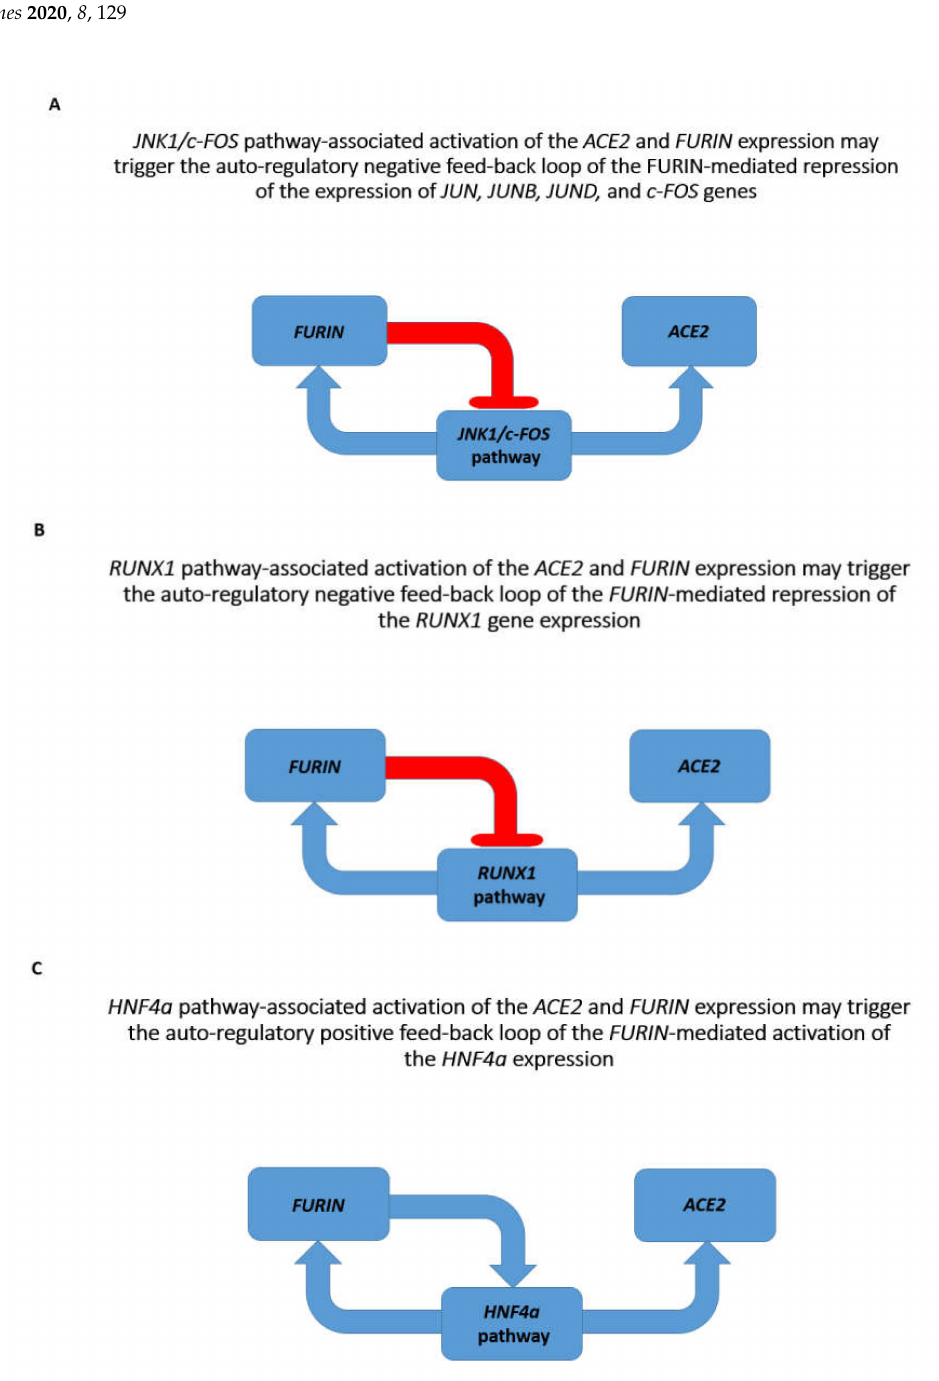
Figure 2. Pathways and genes a ff ecting the newly emerged SARS-CoV-2 virus-related host targets. ( A ). JNK1 / c-FOS pathway-associated activation of the ACE2 and FURIN expression may trigger the auto-regulatory negative feed-back loop of the FURIN -mediated repression of the expression of JUN, JUNB, JUND, and c-FOS genes. ( B ). RUNX1 pathway-associated activation of the ACE2 and FURIN expression may trigger the auto-regulatory negative feed-back loop of the FURIN -mediated repression of the RUNX1 gene expression ( C ). HNF4a pathway-associated activation of the ACE2 and FURIN expression may trigger the auto-regulatory positive feed-back loop of the FURIN -mediated activation of the HNF4a